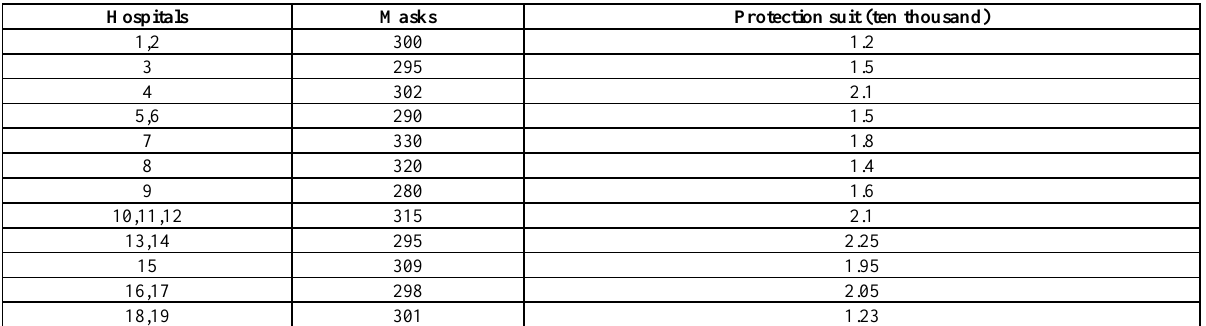
Table 3. The distribution map of the